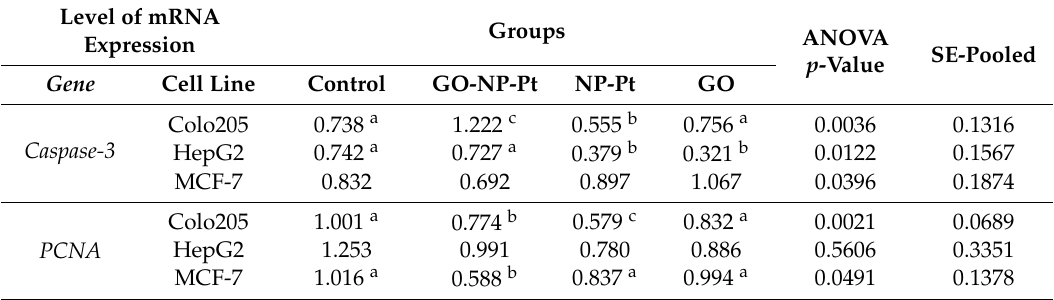
Table 2. Caspase-3 and PCNA expression profile in Colo205, HepG2, and MCF-7 cancer cell lines after GO-NP-Pt, NP-Pt, and GO